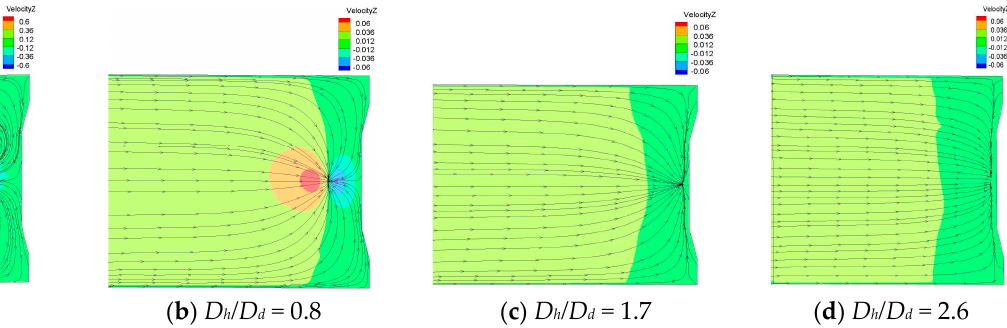
Figure 10. Suction sump flow line and axial flow velocity distribution (section 2 - 2, unit m/s).